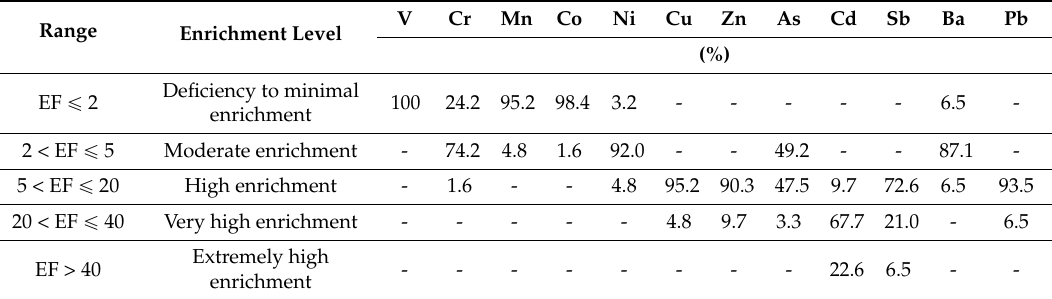
Table 3. Percentages (%) of EFs in each enrichment level for potentially toxic elements in settled dust in the Beijing urban area.